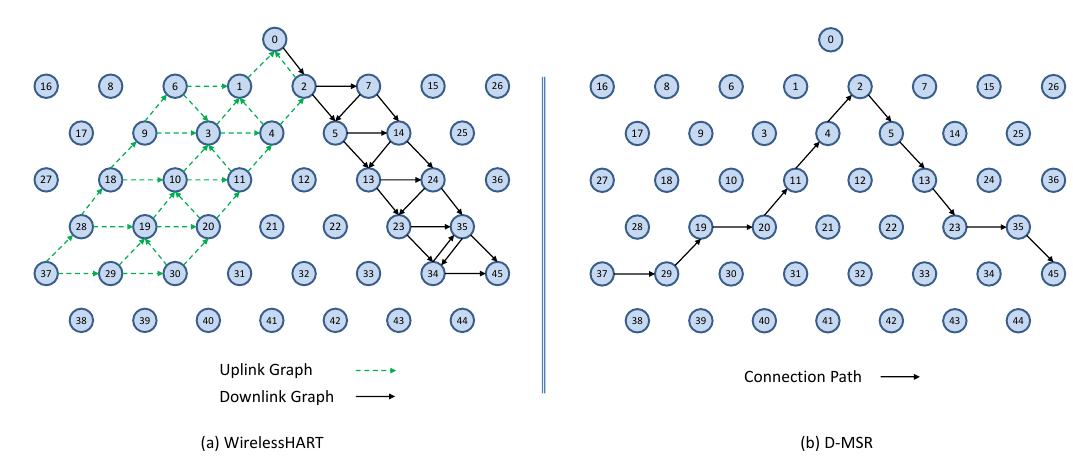
Figure 19. End-to-end connection between nodes 37 and 45 in WirelessHART ( a ) and D-MSR ( b ).